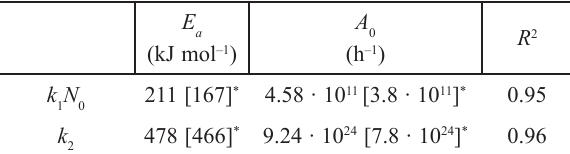
Table 3 – Frequency factors, A of Interface Nucleation and Surface Nucleation in phase trans- formation from anatase to rutile (at T > 600